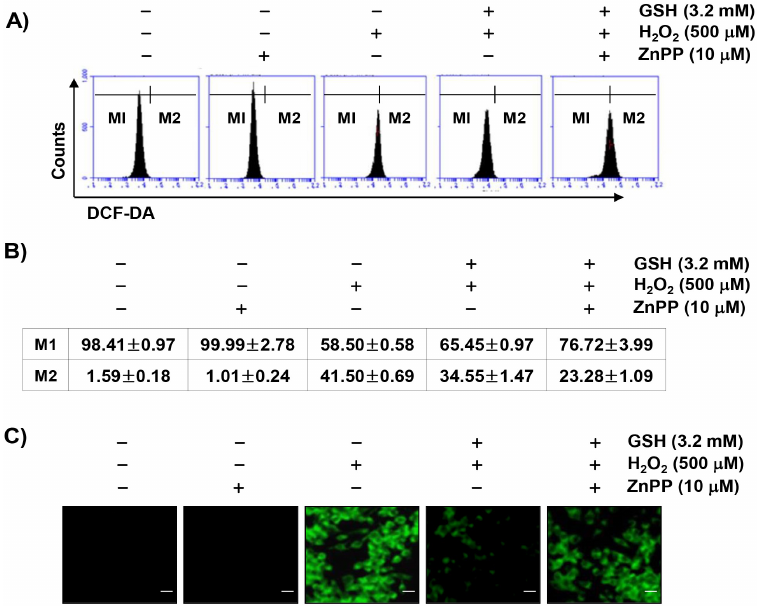
Figure 4. Inhibition of H 2 O 2 -induced ROS generation by glutathione in RAW 264.7 cells. Cells were pretreated with 3.2 mM glutathione or 10 μM ZnPP for 1 h and then treated with 500 μM H 2 O 2 for 1 h. ( A ) After staining with 2’,7’-dichlorofluorescein diacetate (DCF-DA) fluorescent dye, DCF fluorescence was monitored by flow cytometer and fluorescent signals were displayed as histograms. ( B ) M1 is placed around the cells where no ROS is generated. M2 represents the percentage of cells that increase the reactive oxygen species (ROS) production. The data were shown as the mean ± SD obtained from three independent experiments. ( C ) Images were obtained by a fluorescence microscope (original magnification, ×200). Images are representative of at least three independent experiments. Scale bar, 20 μm.